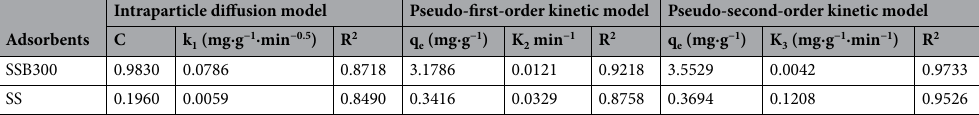
Table 2. Fitting parameters of ammonium adsorption kinetics.